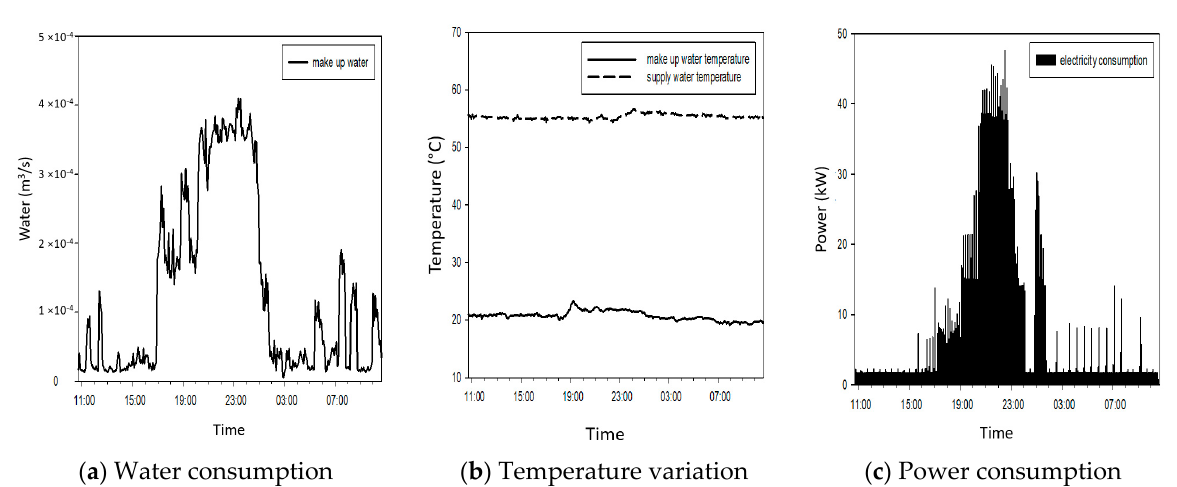
Figure 4. Heat pump water heating system.